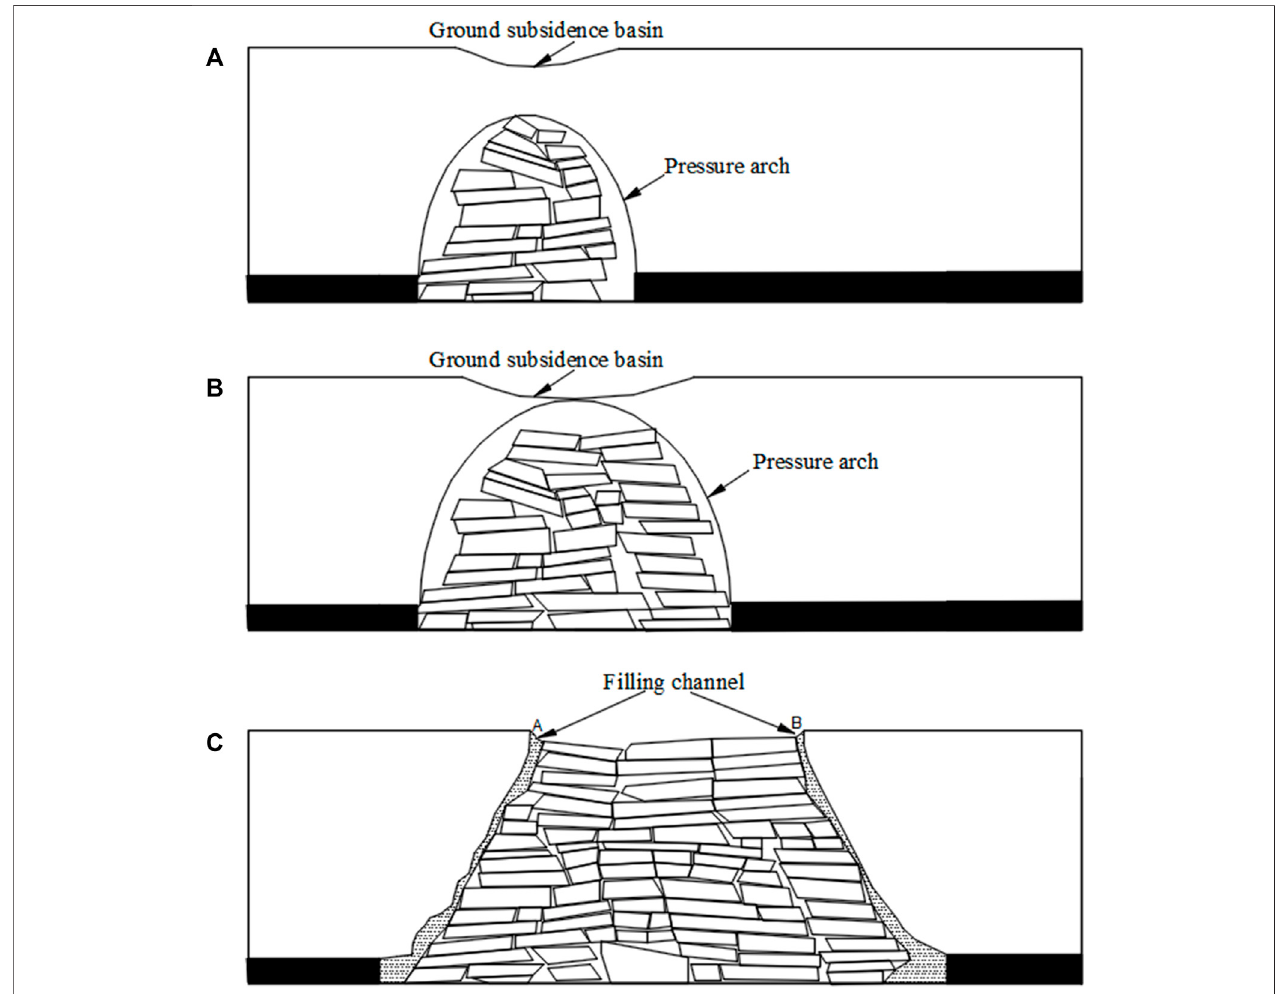
FIGURE 8 | Failure mode of strata in the two zone mode.